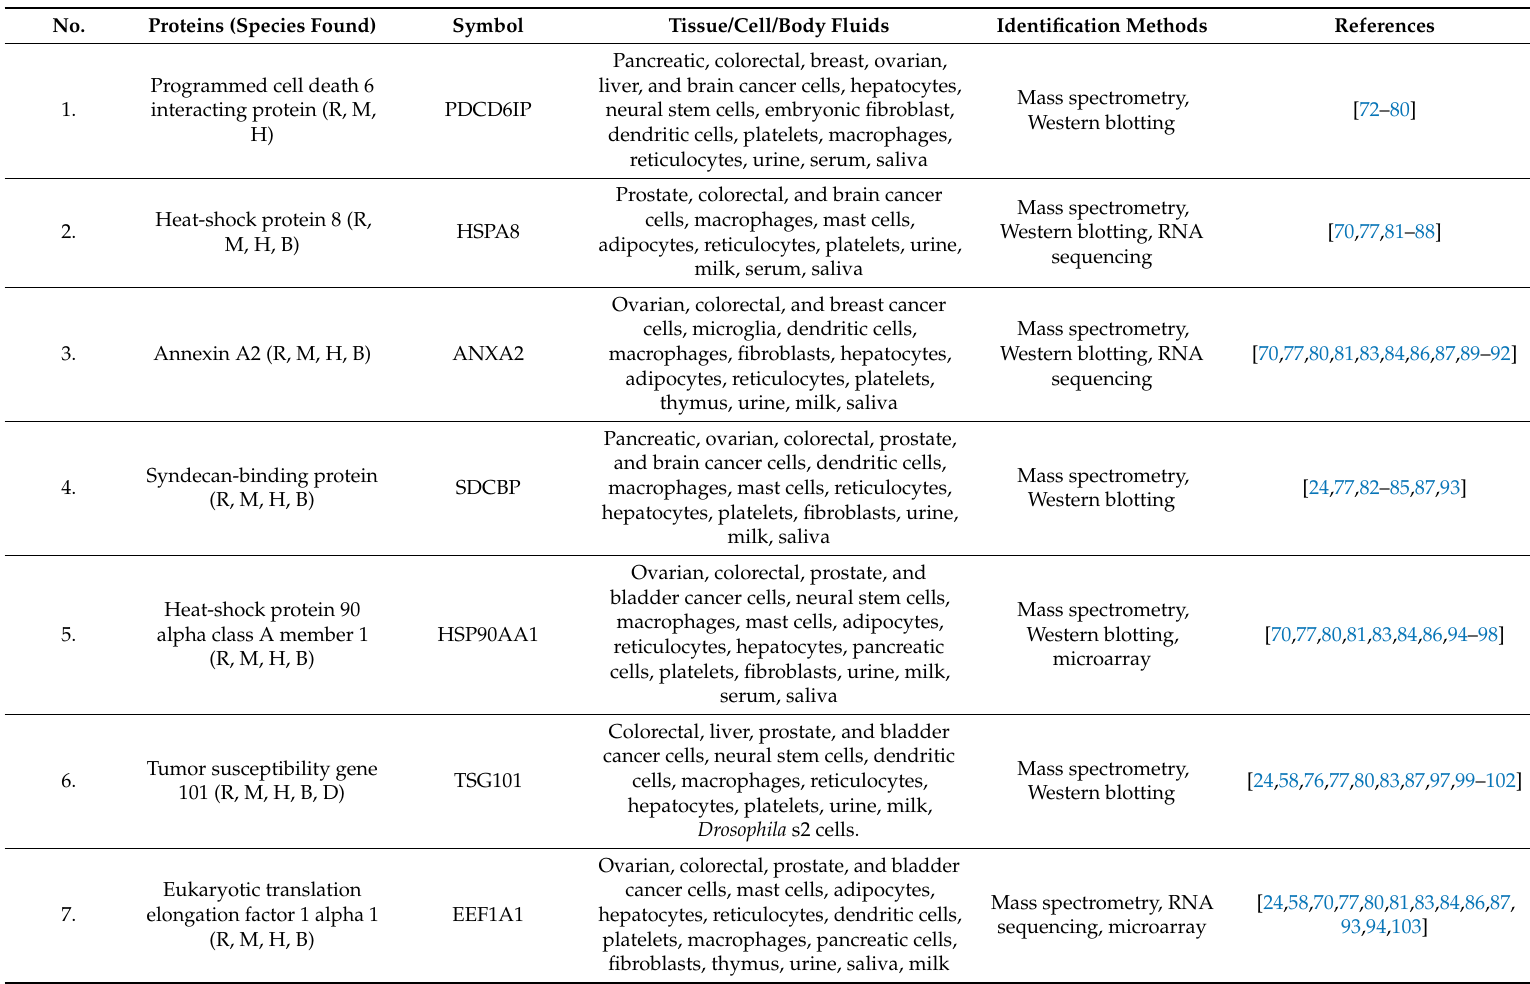
Table 1. List of the top exosome proteins. The classification is based on numbers of reported occasions, and includes protein names, symbols, report times, cell origins and species, and methods used for identification. (Reported species: R = rat, M = mouse, H = human, B = bovine, D = Drosophila ).